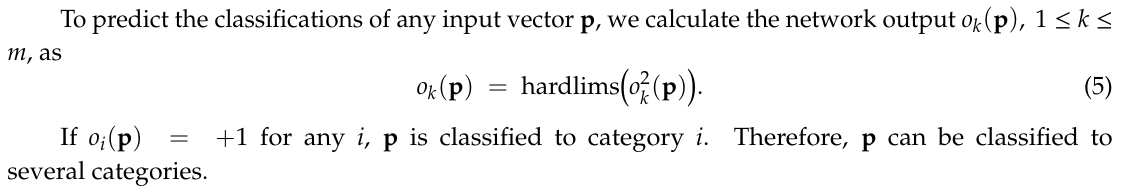
Figure 4. Diagram of multi-label (ML)-Scheme for multi-label classification.